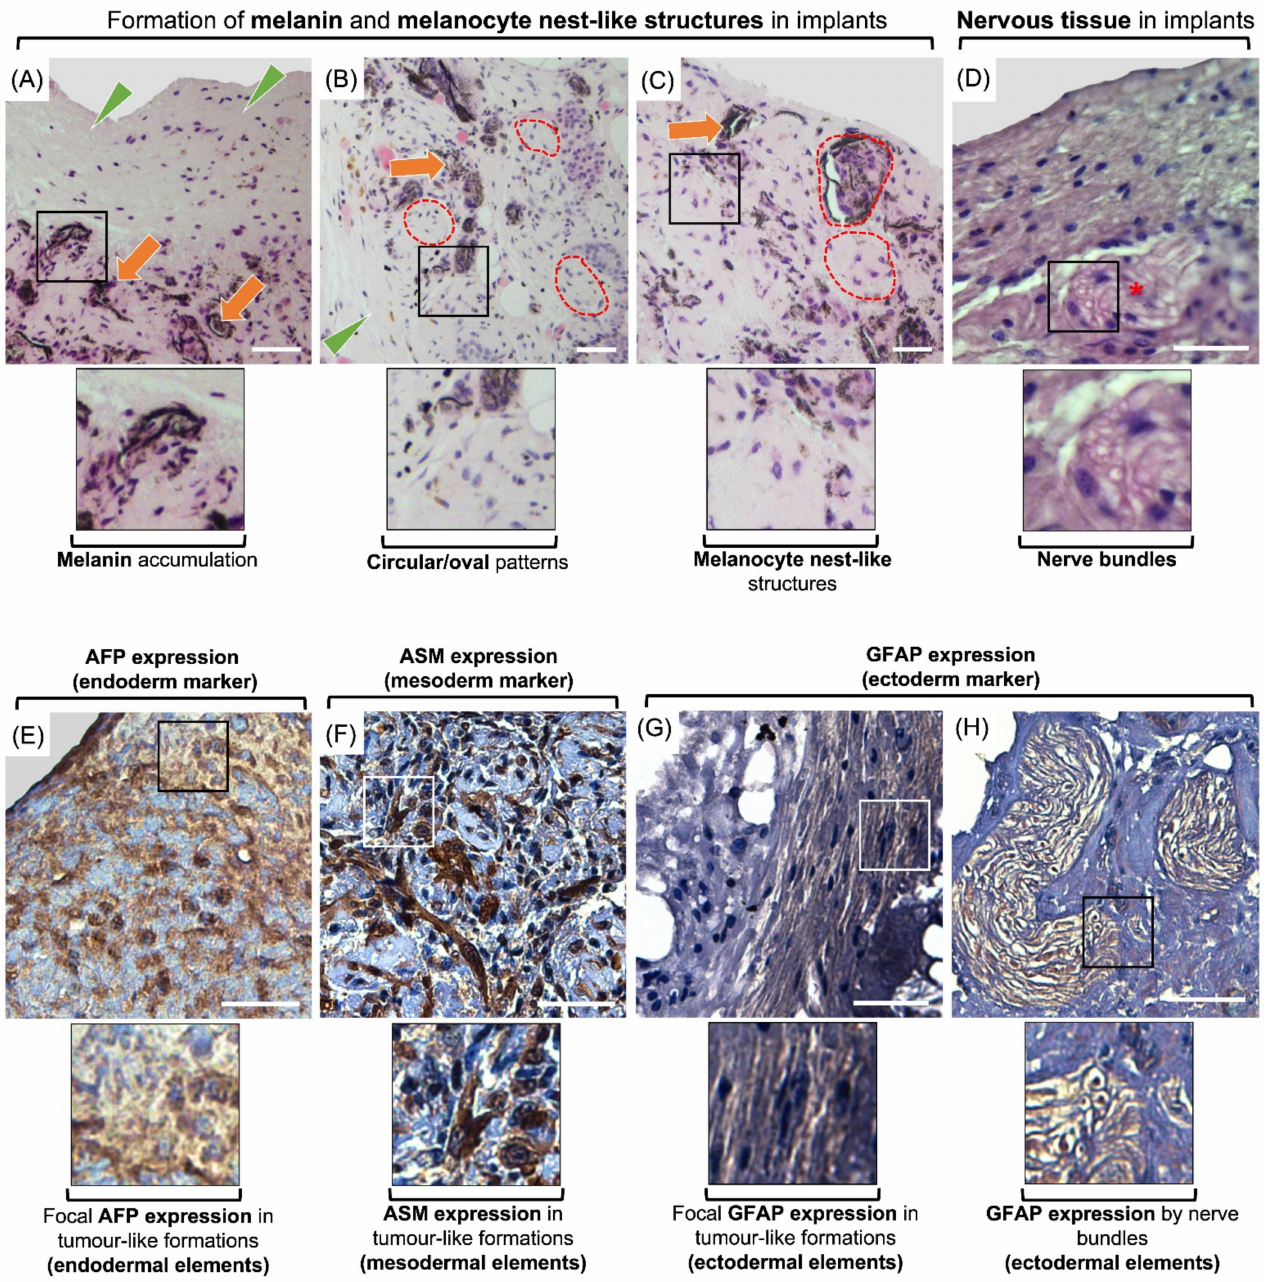
Figure 7. Representative photomicrographs captured from (immuno)histological sections of dedifferentiated cell implants. Implants were stained using H&E ( A – D ) or labelled with lineage-specific antibodies including AFP ( E ), ASM ( F ), or GFAP ( G , H ). The implants were surrounded by a dense fibrous capsule (green arrowhead) ( A , B ). Implants developed into tumor-like growth formations containing circular and/or oval patterns as well as large numbers of melanocytes with remarkable accumulation of melanin pigments (orange arrows) ( A – C ). The distribution pattern of the cells resembled nests of melanocytes (red broken lines) ( B , C ). Within these formations were also located the bundles resembling those of peripheral nerves (asterisk) ( D ). AFP as endoderm marker was expressed in foci of implanted cells/EBLCs ( E ). Focal AFP expression can be attributed to endodermal elements in tumor-like formations. Also, limited expression of ASM was observed by the cells inside and surrounding the circular patterns ( F ), which can be deemed as the presence of differentiated myofibroblasts. Small foci within the formations and nerve bundle-like structures both appeared positive for GFAP as neuroectodermal marker ( G , H ), which can point at development of ectodermal component within the formations. Squares display higher magnification (Scale bar = 50 µ